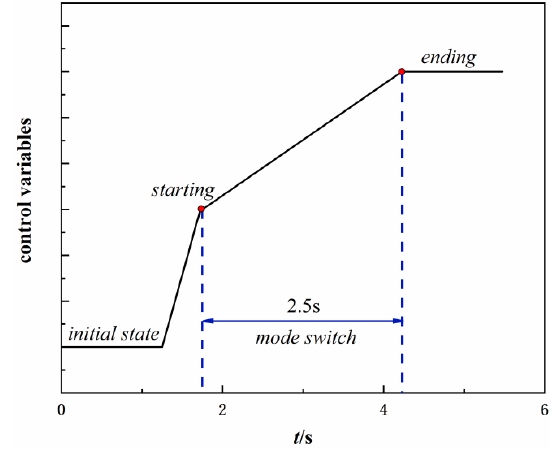
Figure 7. Change curves of optimized control variables.